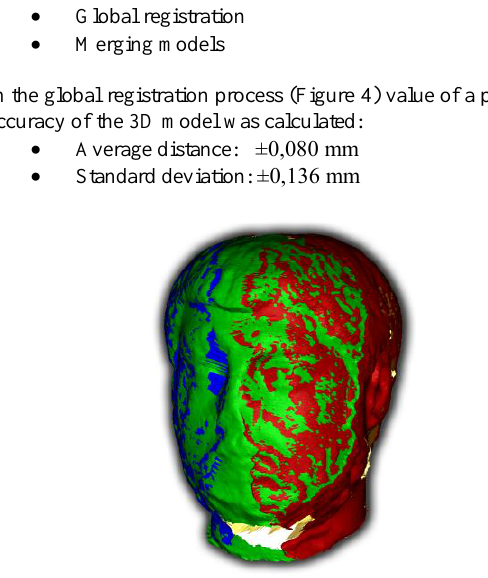
Figure 4. Global registration